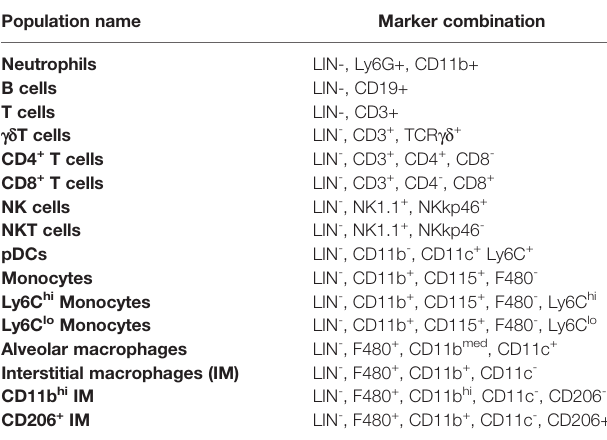
TABLE 4 | General gating strategy for identi fi ed immune cell subsets and the used marker combination for de fi